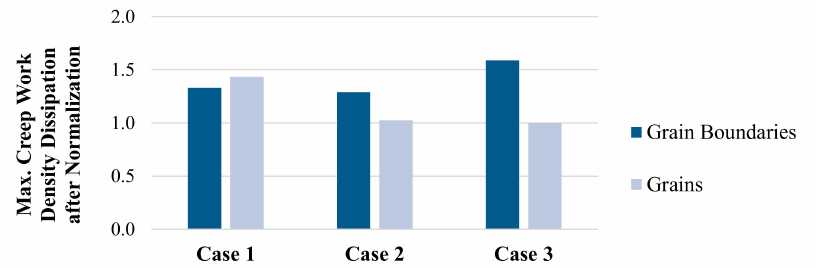
Figure 13. Normalized max. creep work density dissipated at the end of the fourth